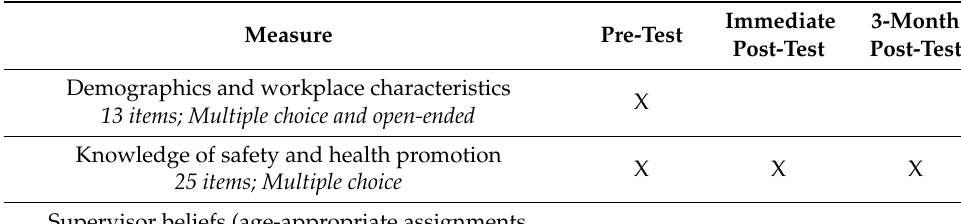
Table 1. Table of Measures, number of items, and response categories.